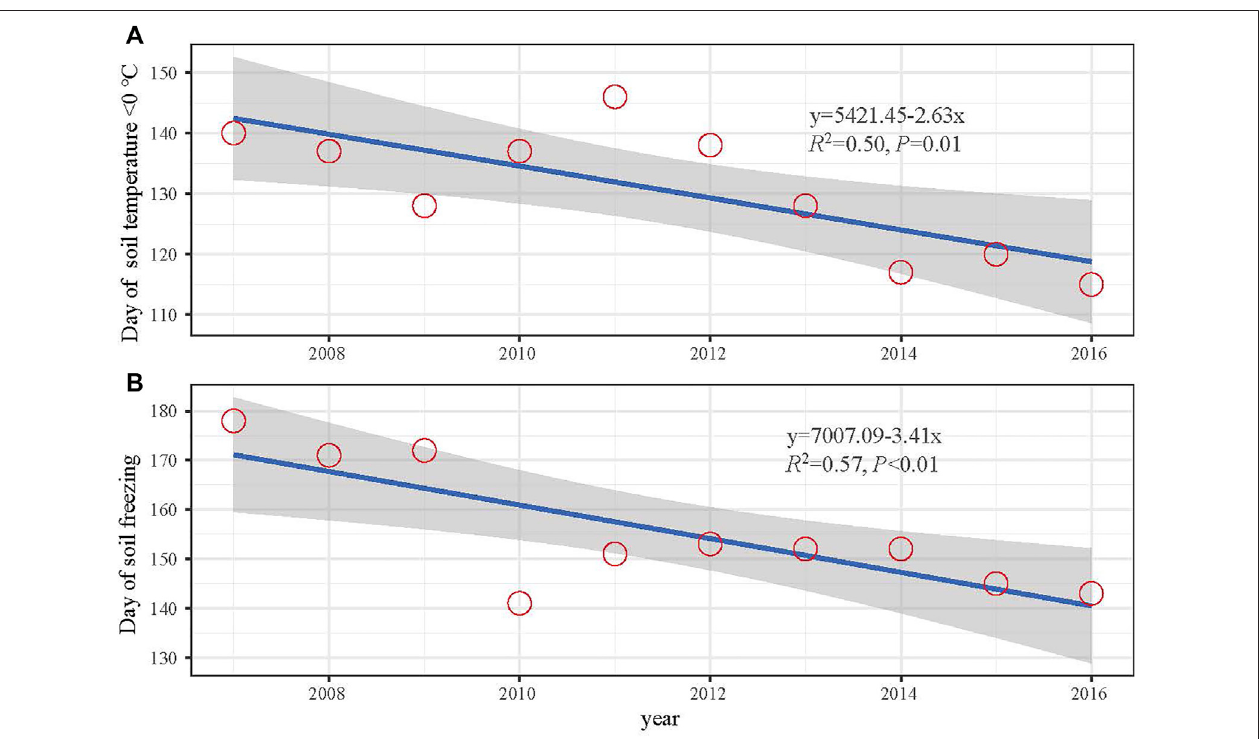
FIGURE 5 | Inter-annual variation of day number of seasonal frozen (A) and averaged topsoil temperature below 0 ° C (B) .